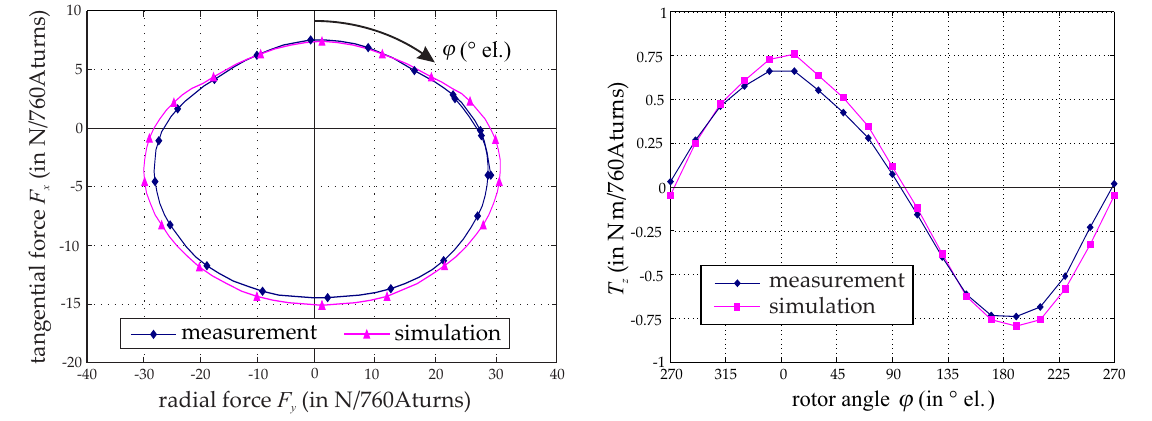
Figure 13. Comparison of the finite-element simulated and measured single-phase characteristics of the suspension forces ( left ), and the torque ( right ).